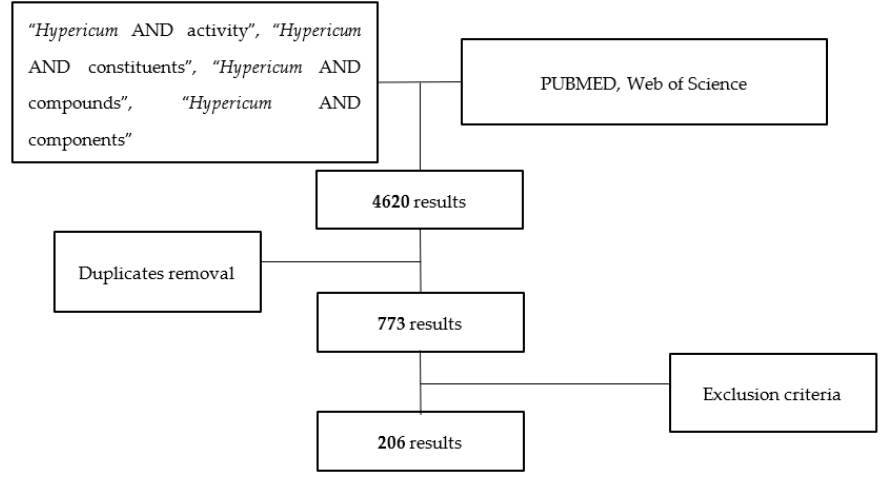
Figure 1. Data-screening methodology.